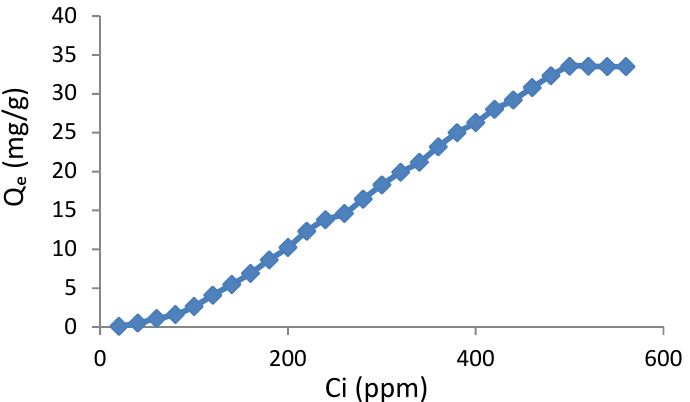
Figure 3. Effect of initial concentration (Ci) of adsorbate on the adsorption of MR dye on D. viscosa plant bark.